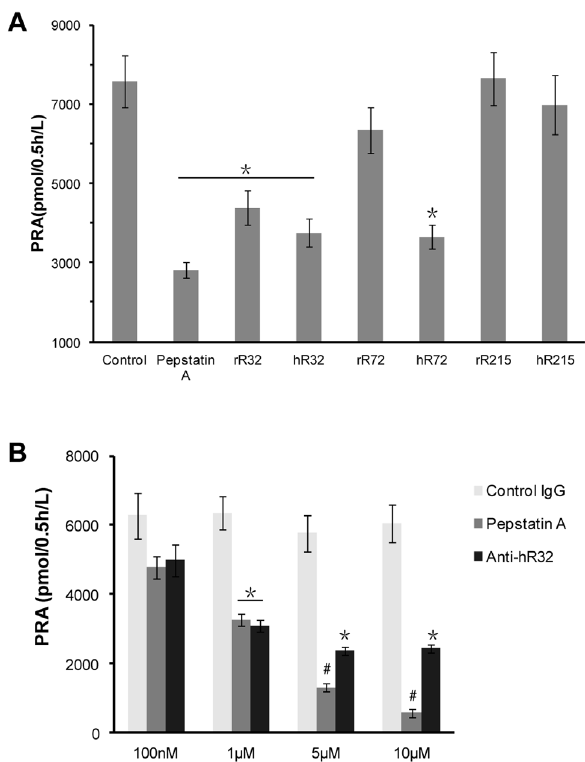
Figure 3. The purificated IgG against the R32 and R72 peptides reduced the level of PRA. A. Purificated antibodies (1 m M) were preincubated with human plasma containing a high PRA (20 ng of angiotensin I/h/ml), excess renin substrate were added, then PRA was tested by RIA. The PRA was significantly decreased by 50% in the R32 and hR72 groups, while no obvious change in the R215 groups. B. Different concentrations (100 nM, 1 m M, 5 m M, and 10 m M) of the anti- hR32 IgG were preincubated with the human plasma. The dose- response chart showed that more than 50% of PRA was inhibited by 5 m M anti-hR32 IgG in contrast to the control IgG. * P , 0.05 and # P , 0.01 vs the control group.